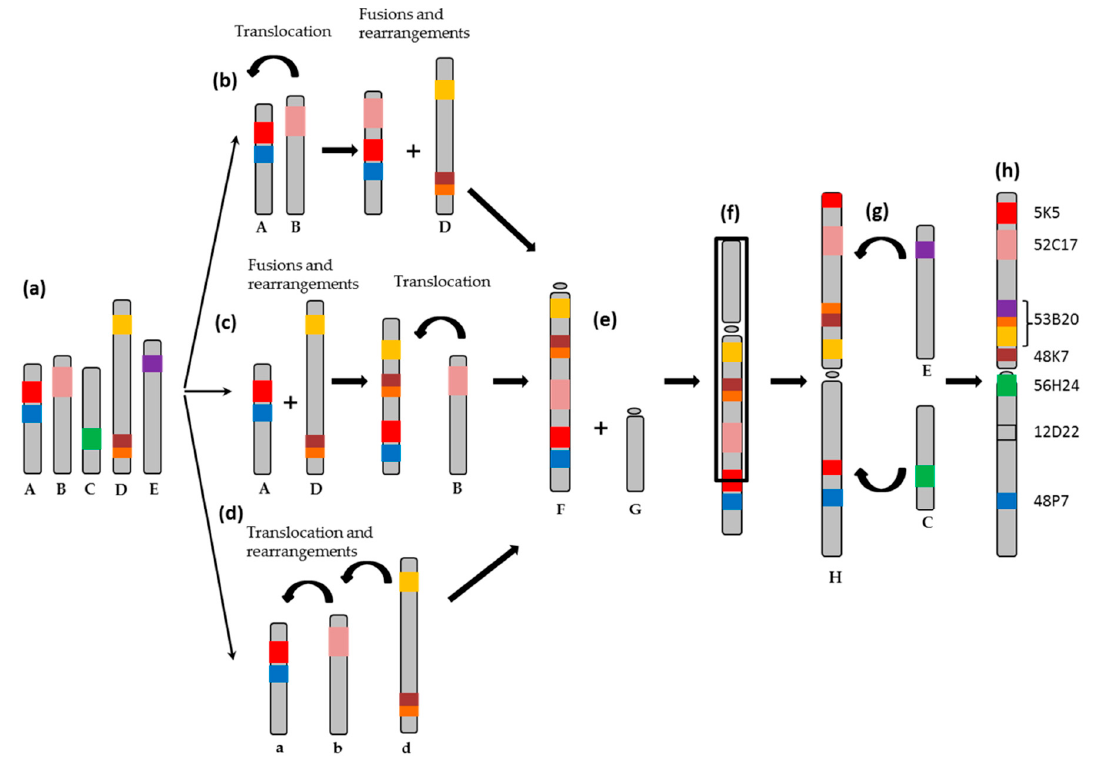
Figure 6. Evolution of the proto sex- chromosome 1 of S. senegalensis from ancestral chromosomes after evolution of Teleost fish and Euteleosteomprpha. ( a ) A, B, C, D and E represent ancestral chromosomes. ( b – d ) are the proposed paths for the evolution of the chromosome of S. senegalensis . ( e ) Robertsonian fusions. ( f ) Pericentric inversions and rearrangements. The black square represents the region in which pericentric inversion occurred. ( g ) Translocation and rearrangements events. ( h ) Current metacentric proto sex-chromosome of S. senegalensis .